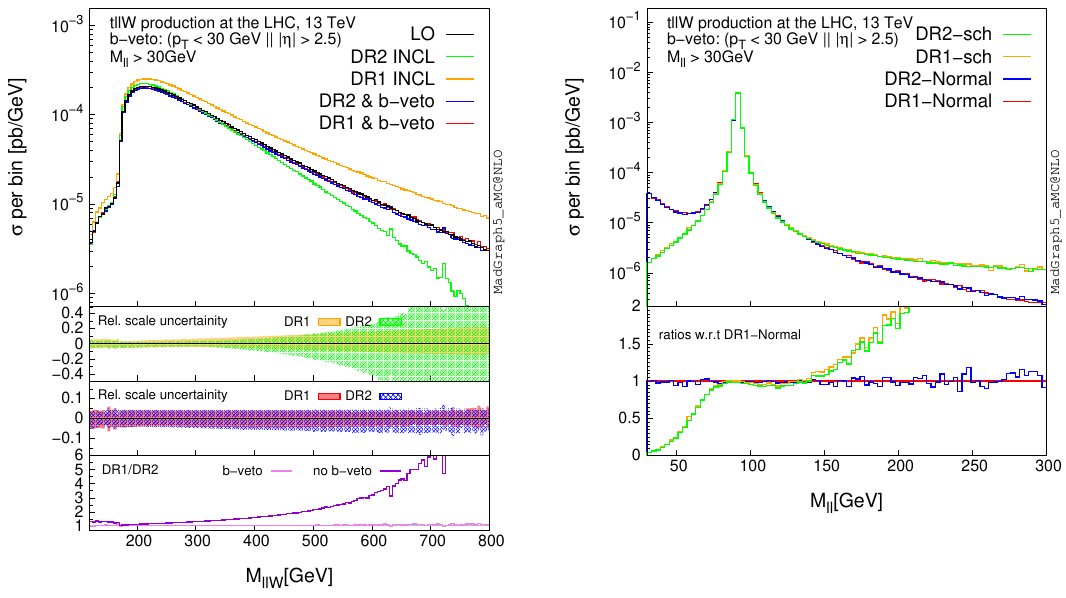
Figure 3 . ( Left ) The differential cross section in the invariant mass bins of the W‘ + ‘ − system for the tW‘‘ process at NLO in QCD. Predictions are given for the DR1 and DR2 overlap removal schemes before and after including a veto on central ( | η | < 2 . 5 ) or hard ( p T > 30 GeV) b -quarks. The first two insets depict relative scale uncertainties and the third shows the DR1/DR2 ratio. ( Right ) DR1 and DR2 predictions of the invariant mass of the lepton pair, M . Full predictions labelled l + l − ‘Normal’ case, are shown alongside the ‘sch’ case, which only includes diagrams with a Z boson in the s -channel. The inset shows the ratios of the distributions w.r.t. to the ‘Normal’ DR1 prediction.